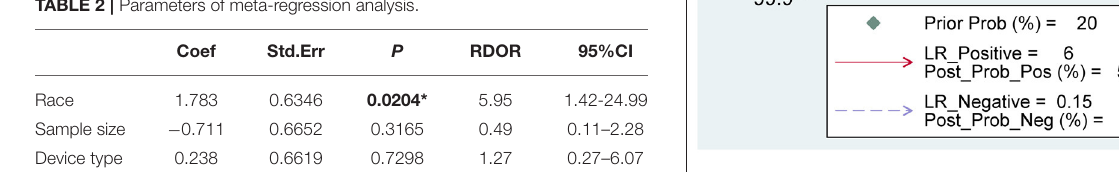
TABLE 2 | Parameters of meta-regression analysis.